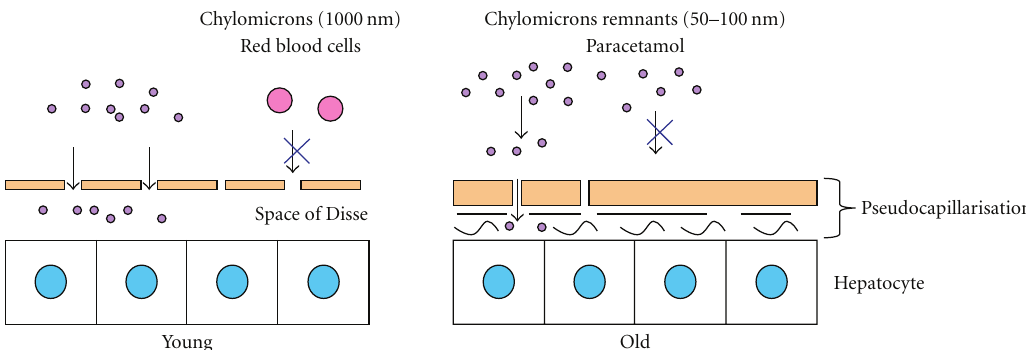
Figure 2: Age-related pseudocapillarisation of the liver sinusoid impairs the transfer of lipids (chylomicrons remnants) and paracetamol across the fenestrated liver sinusoidal endothelial cells (LSECs). Adapted from Le Couteur et al., 2002 (20).